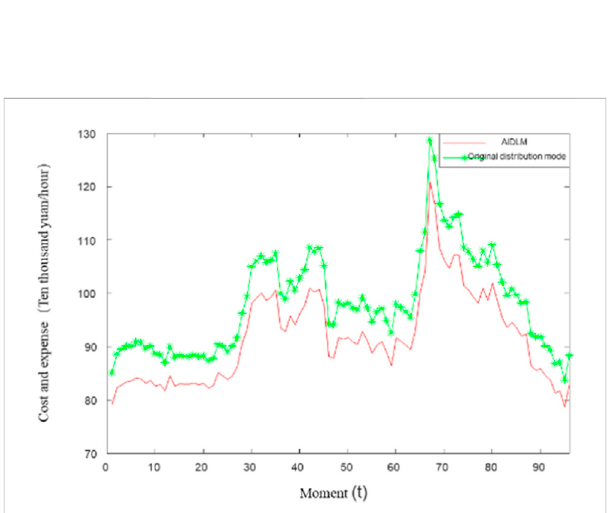
FIGURE 7 The statistics of knowledge validity indexes under different extraction depths in the lumped load case.